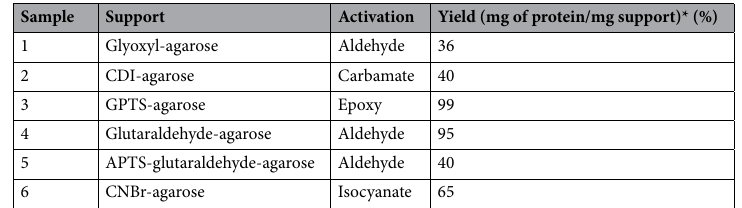
Table 1. Immobilization of RNase A on different supports. *Bradford Assay. Loading: 20 mg RNase A/g support. APTS (3-aminopropyl) triethoxysilane, CDI N , N ′ -carbonyldiimidazole, GPTS (3-Glycidyloxypropyl) trimethoxysilane, CNBr cyanogen